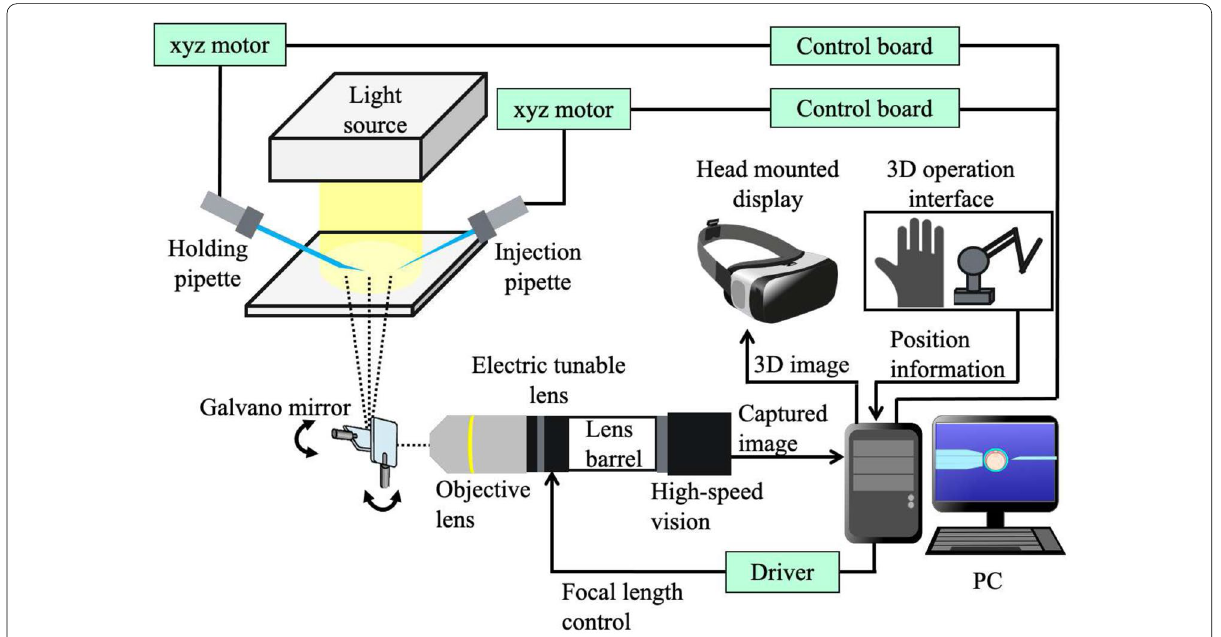
Fig. 4 Configuration of the proposed